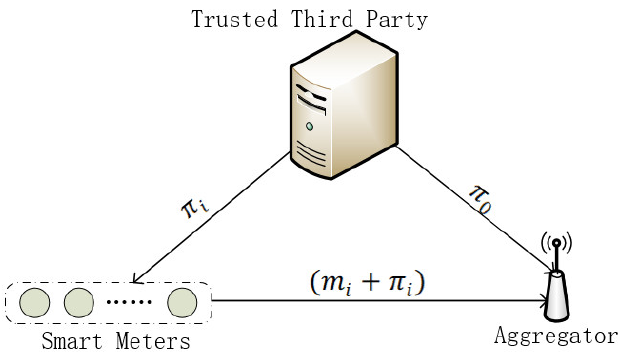
Figure 1. Entities in the trusted third party model.